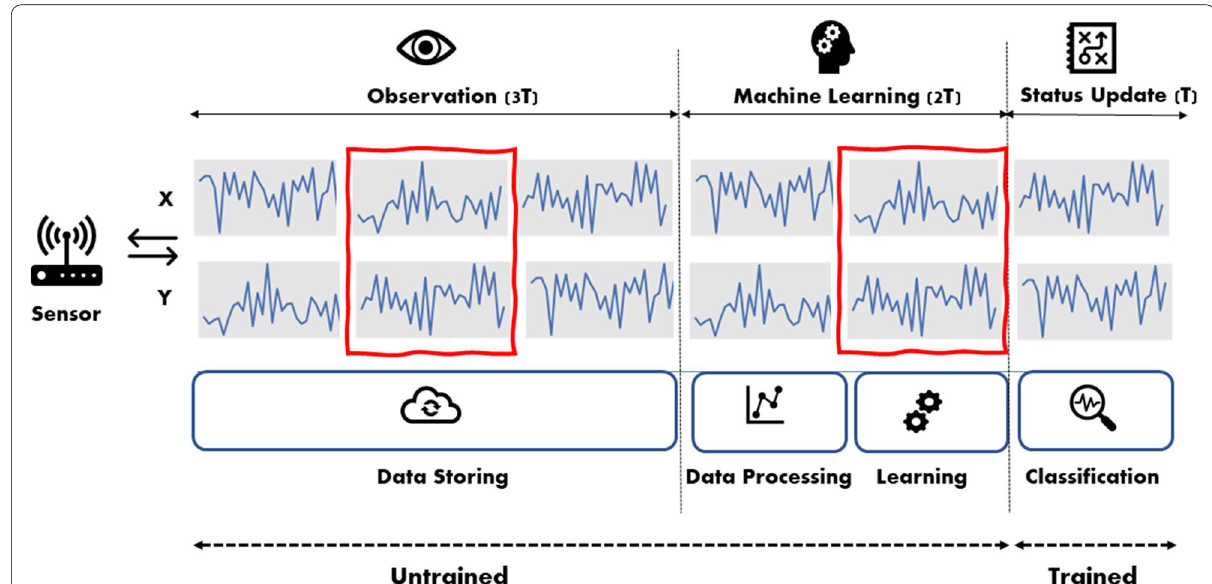
Fig. 3 The workflow of Fog computing in the present study. Fog computing comprises three distinctive modes in a single time sequence: observation, machine learning, and status update. The observation phase executes streaming data storing. The Machine Learning phase does data processing and learning the model. The status update phase carries out a classification of a fan status with the trained model. A red box refers to a sliding window corresponding to a process of the workflow on the timeline. For example, the box which is on the second from the left indicates data storing. Likewise, the fifth box from the left is of learning the